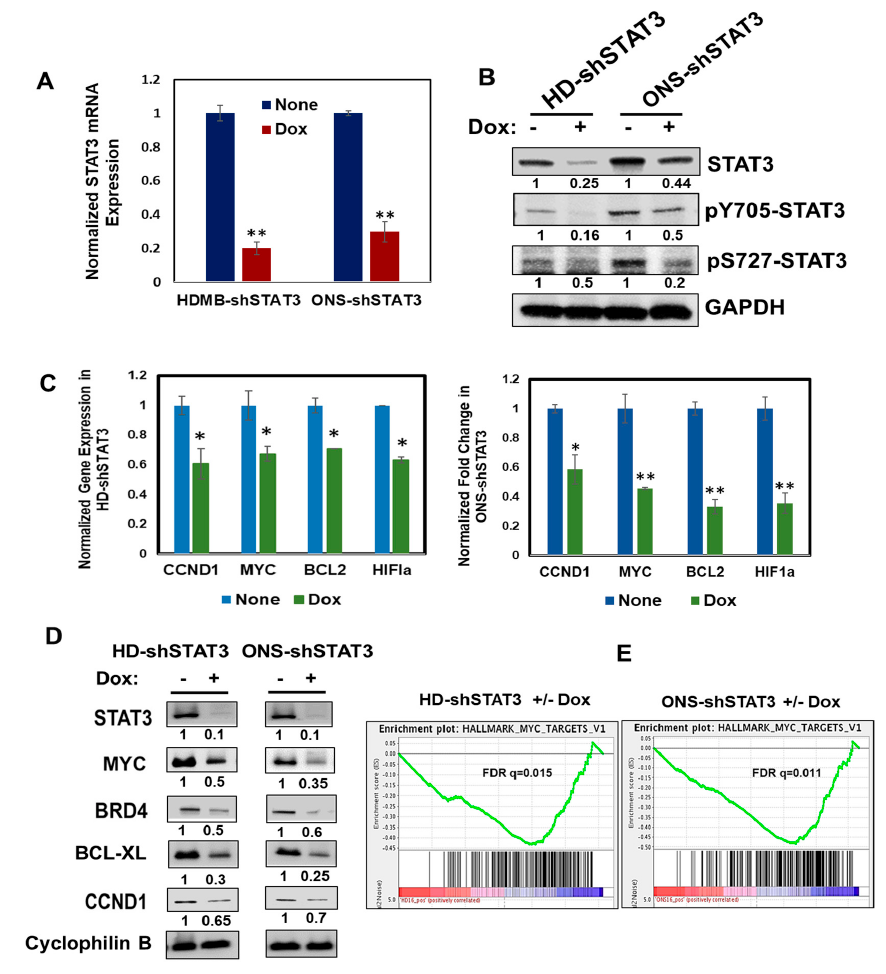
Figure 1. E ff ect of STAT3 genetic KD on STAT3 targets in vitro . ( A ) STAT3 mRNA expression in HD- shSTAT3 and ONS-shSTAT3 MB cells expressing Dox-inducible STAT3 shRNA was validated by qPCR. Cells were either treated with Dox (0.5 µg/mL) for 48 h or left untreated before harvesting the RNA. ** Represents p < 0.01 for Dox-treated cells versus control cells. ( B ) HD-shSTAT3 and ONS- shSTAT3 MB cells were treated as in ( A ) prior to making the whole cell extract (WCE). Expression levels of STAT3, pY705-STAT3 and pS727-STAT3 were analyzed by Western immunoblot analysis and GAPDH was used as a loading control. ( C ) Cells were treated as in ( A ) and STAT3 target gene expression was analyzed by qPCR. * Represents p < 0.05, ** p < 0.01. ( D ) WCEs from Dox-treated HD-shSTAT3 and ONS-shSTAT3 MB cells were analyzed by Western blot for the expression levels of STAT3 target genes. Cyclophilin B acts as a loading control. ( E ) Enrichment of MYC target genes is shown in HD-shSTAT3 and ONS-shSTAT3 cells after STAT3KD by GSEA plot. FDR represents false discovery rate; FDR q < 0.25 is considered signi fi cant. The uncropped bolts are shown in Sup- plementary Materials fi le S1. 3.2. STAT3 KD A ff ects Cell Viability, Apoptosis, Cell Growth and Migration To assess the e ff ects of STAT3 genetic KD on MB cell growth, we investigated the e ff ect of Dox by MTT assay. After treatment with increasing concentration of Dox for 48